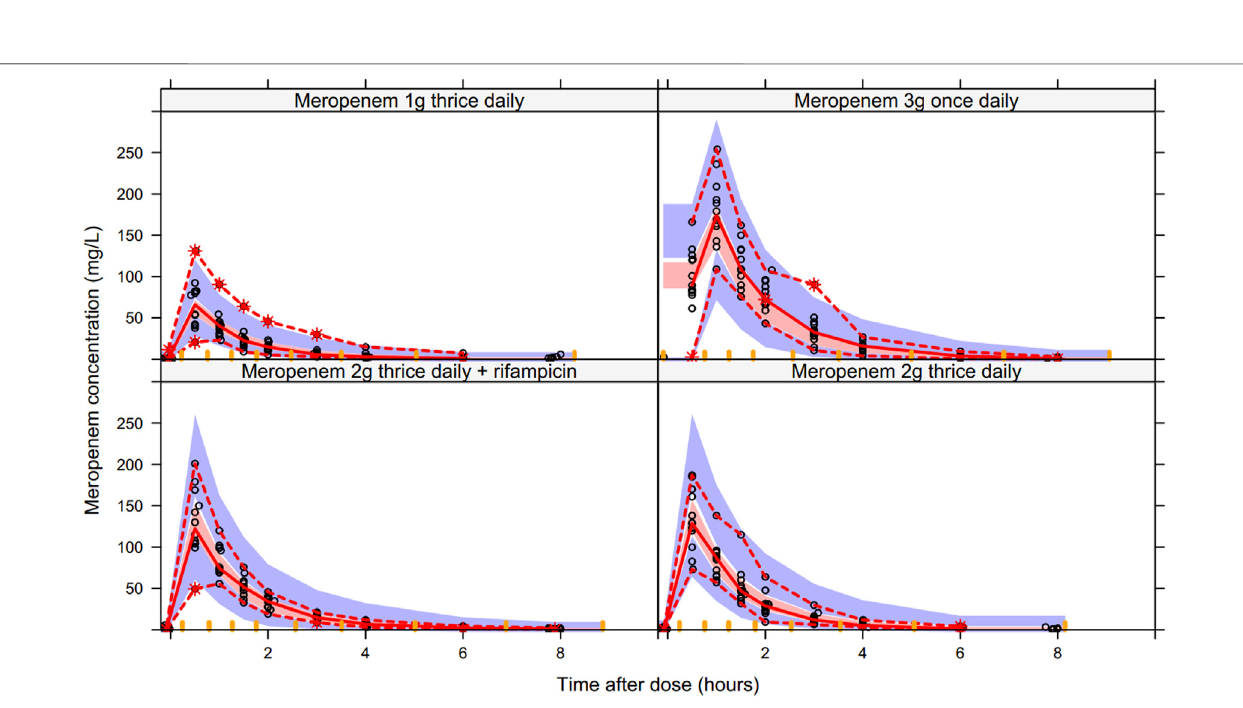
Frontiers in Pharmacology |